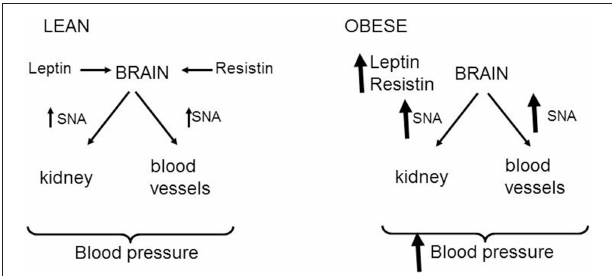
FIGURE 4 | Schematic representation of the effects of leptin and resistin on sympathetic nerve activity (SNA) to cardiovascular organs. In normal lean states, resistin, and leptin act in the brain to increase sympathetic nerve activity to the kidney and skeletal muscle vasculature. These may influence blood pressure. In the obese state, it is hypothesized that the increased levels of leptin and resistin leads to enhanced levels of sympathetic nerve firing to the kidney and skeletal muscle vasculature that could contribute to obesity-induced hypertension.